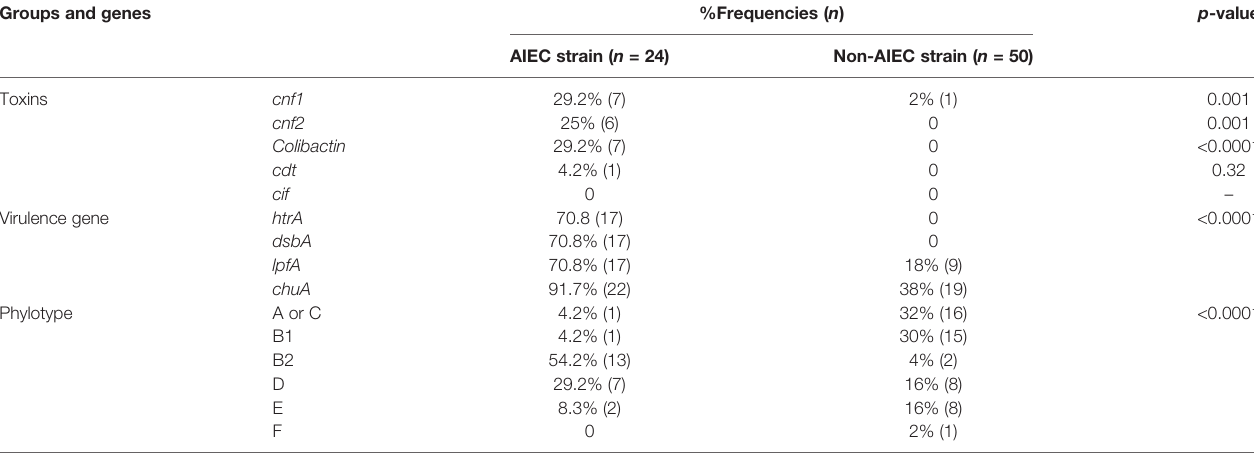
TABLE 4 | Phylogenetic groups and virulence genes detected by PCR in Escherichia coli strains isolated from the study groups. Groups and